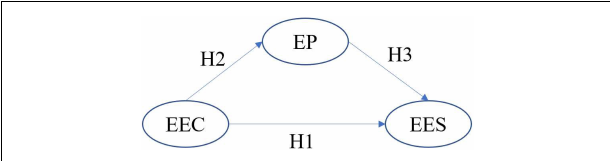
FIGURE 1 | Research framework. EEC, entrepreneurship education curriculum; EP, entrepreneurship practice; EES, entrepreneurship education